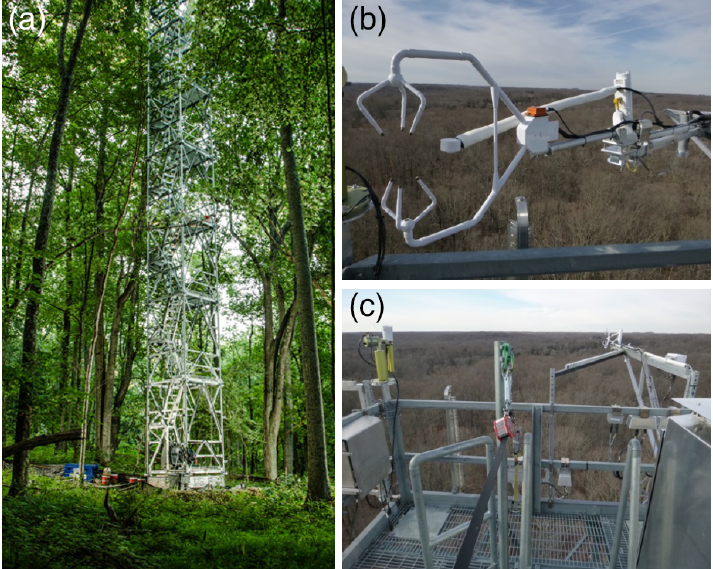
Figure 8. (a) Ecosystem at the NEON SERC tower (credit: Stephen Voss Photography; http://www.stephenvoss.com/). (b, c) EC instru- mentation on top of the NEON SERC tower. (b) Campbell Scientific CSAT-3 three-dimensional sonic anemometer (front) and LI-COR Biosciences LI-7200 infrared gas analyzer (back) on the retracted tower-top boom. (c) Same instrumentation but with the tower-top boom extended at 230 ◦ from true